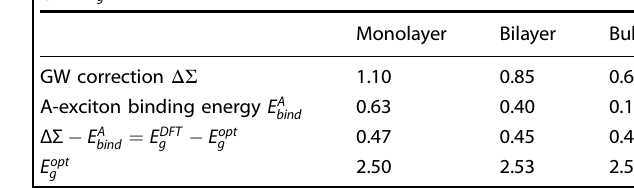
), and optical bind